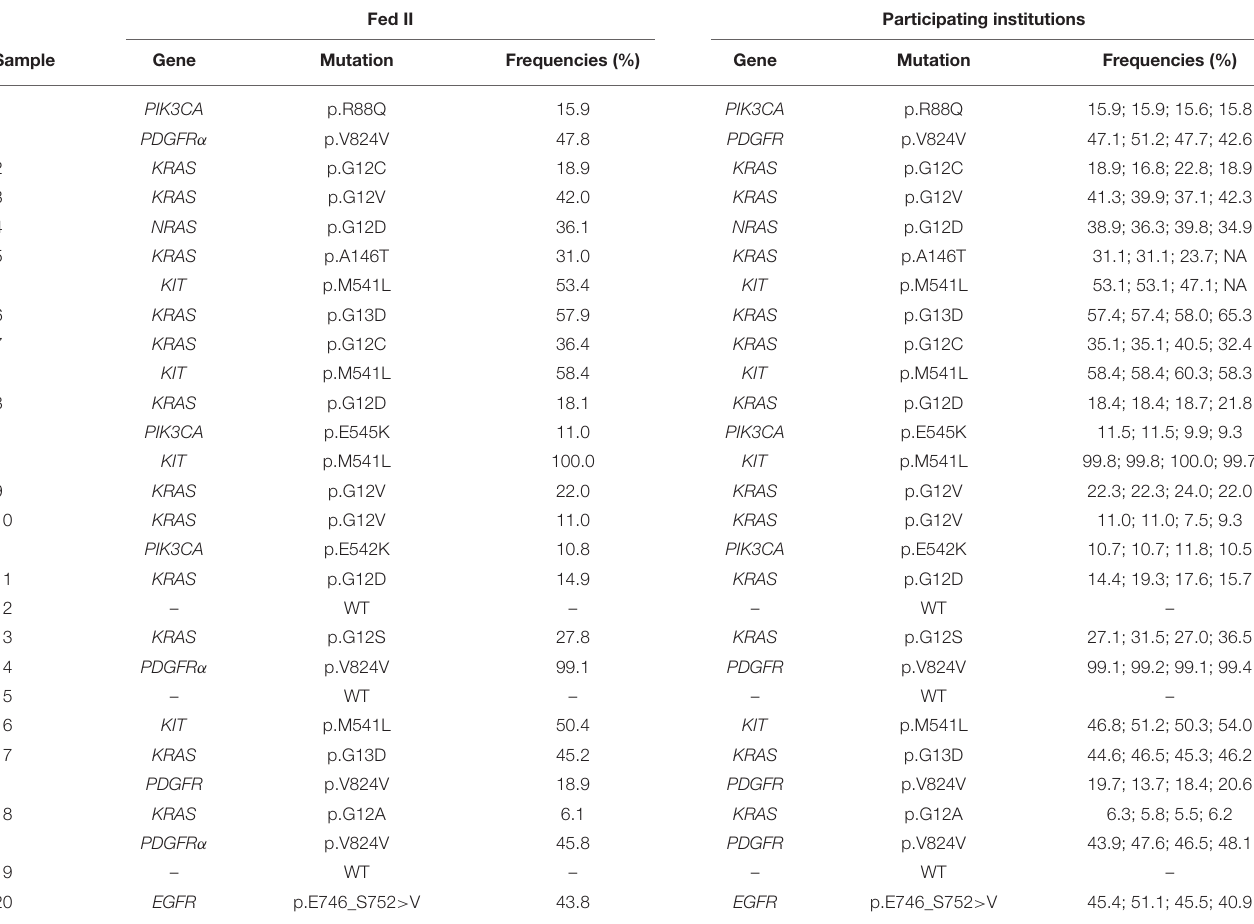
TABLE 1 | Mutations detected on a common sample set ( n = 20) by the University of Naples Federico II with relative allelic frequencies and relative results obtained among all the participating institutions. Fed II Participating